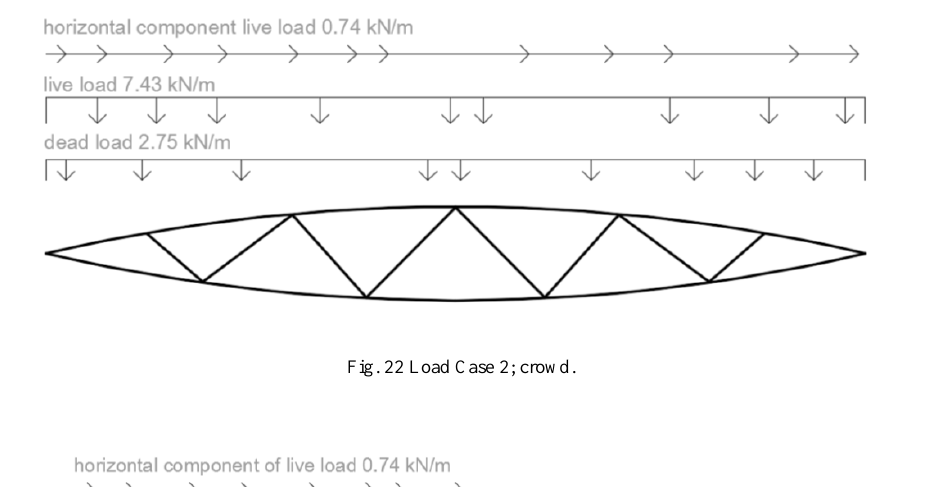
Fig. 21 Load Case 1; vehicle.